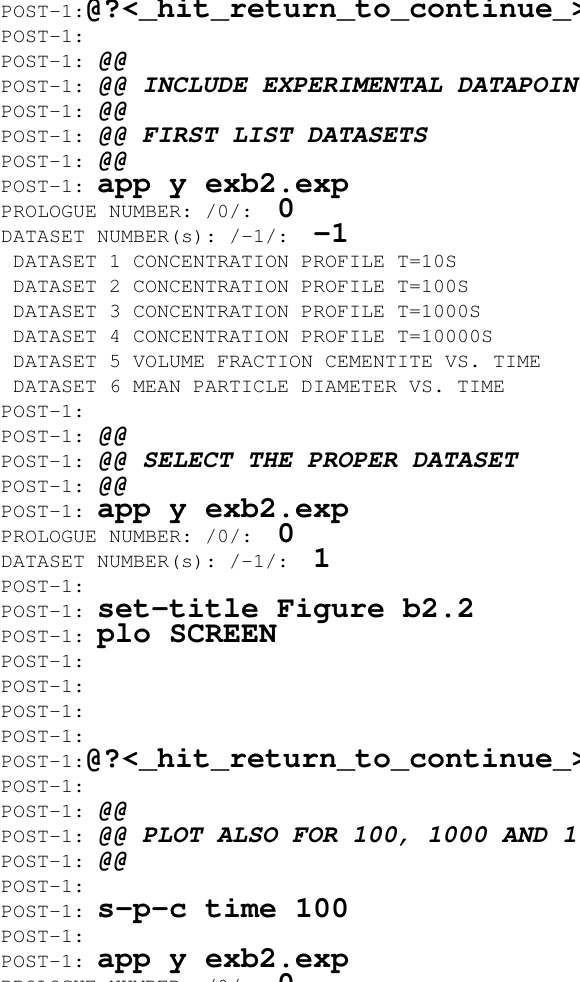
DATASET 1 CONCENTRATION PROFILE T=10S DATASET 2 CONCENTRATION PROFILE T=100S DATASET 3 CONCENTRATION PROFILE T=1000S DATASET 4 CONCENTRATION PROFILE T=10000S DATASET 5 VOLUME FRACTION CEMENTITE VS. TIME DATASET 6 MEAN PARTICLE DIAMETER VS.